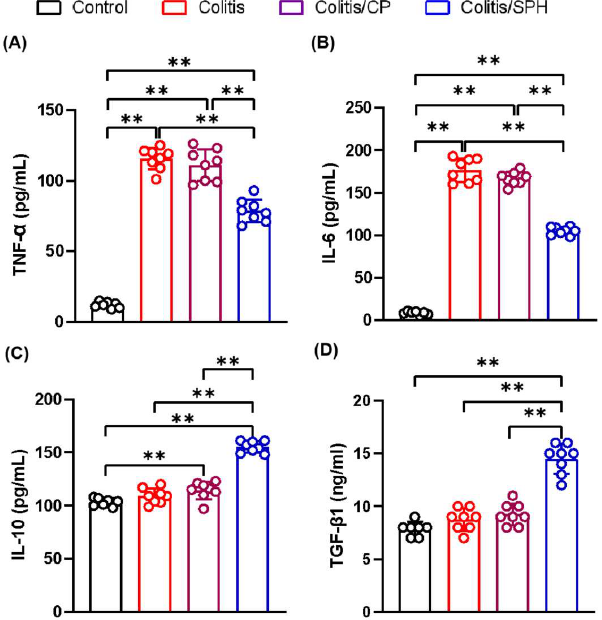
Figure 6. SPH changes the secretion patterns of pro- and anti-inflammatory cytokines in the TNBS- induced colitis model. ( A – D ) The levels of tumor necrosis factor (TNF)-α ( A ), interleukin (IL)-6 ( B ), IL-10 ( C ) and transforming growth factor (TGF)-β1 ( D ) in colon tissues homogenate detected by ELISA. Compared with the Control group (n = 7), the levels of pro-inflammatory cytokines TNF-α and IL-6 increased and the levels of anti-inflammatory cytokines IL-10 and TGF-β1 decreased in the Colitis (n = 8) and Colitis/CP (n = 8) groups, while SPH treatment (n = 8) reduced the levels of TNF- α and IL-6 and elevated the levels of IL-10 and TGF-β1. Data are presented as mean ± SD and ana- lyzed by one-way ANOVA test. **: p < 0.01.